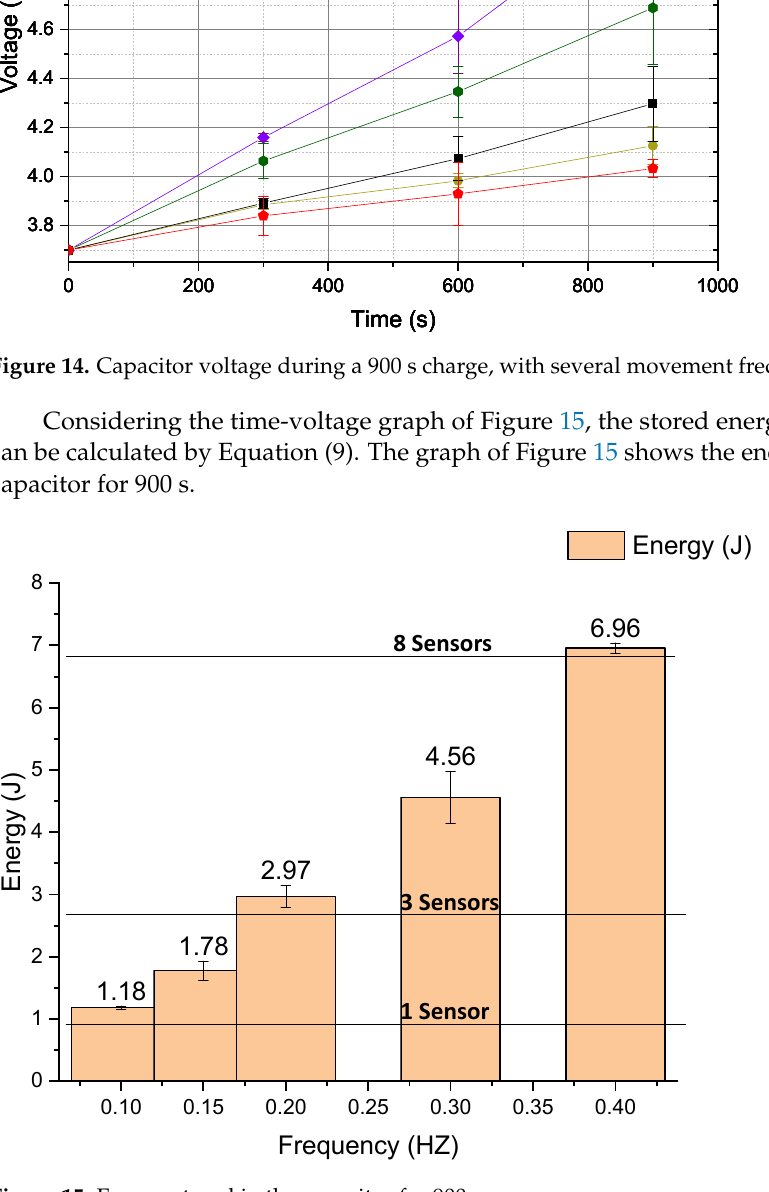
Figure 15. Energy stored in the capacitor for 900 s.